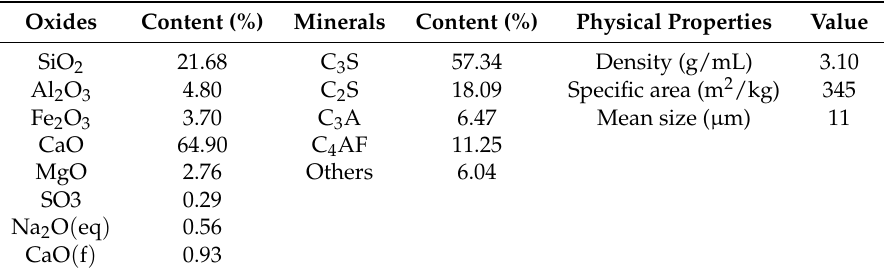
Table 1. Chemical component and physical properties of